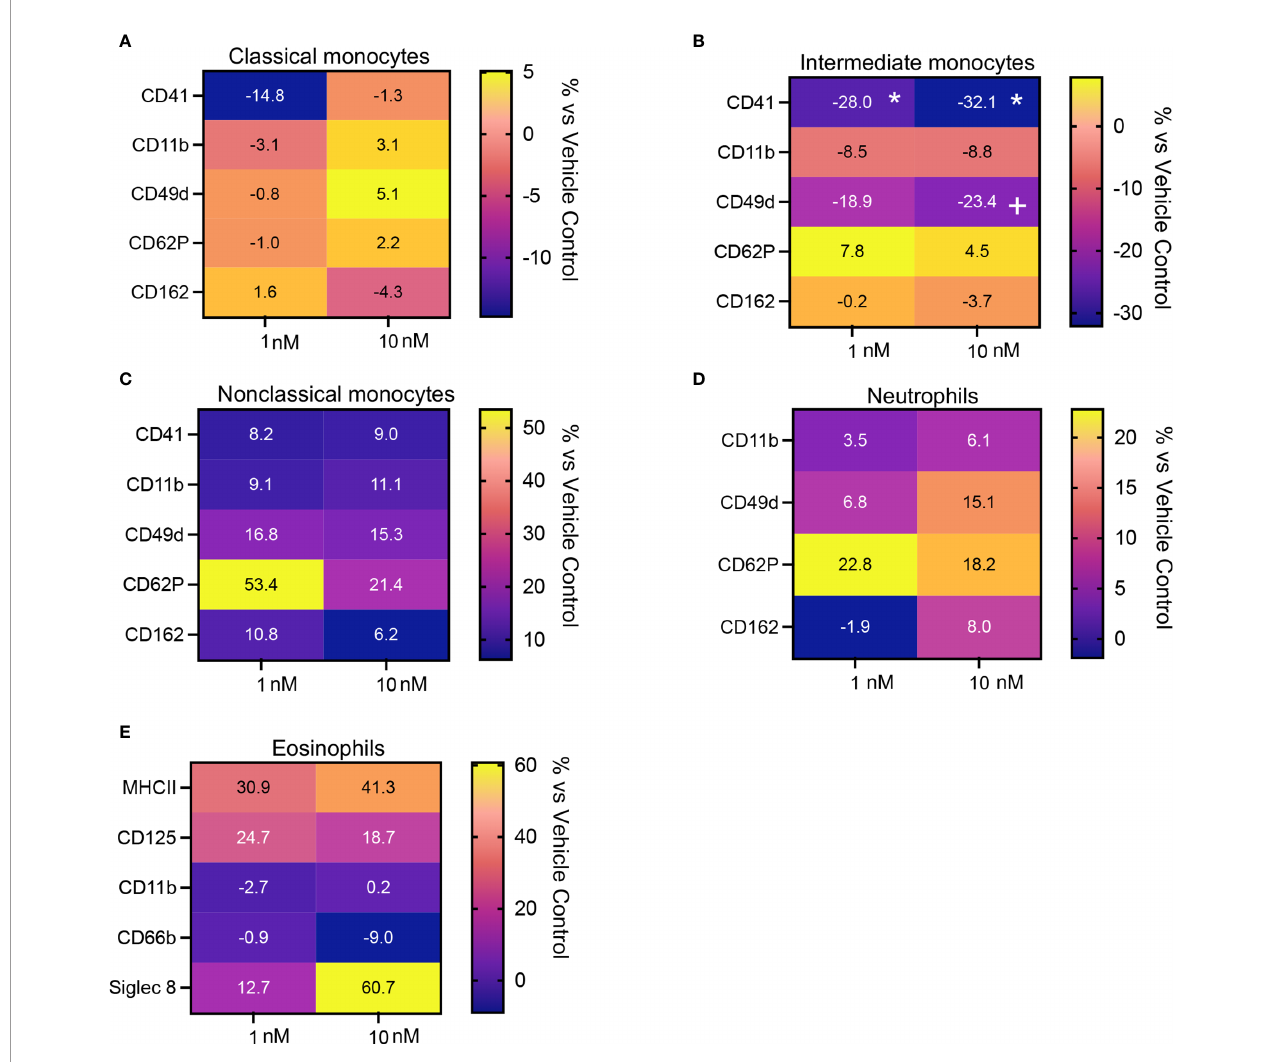
FIGURE 5 | MaR1 regulates the expression of activation markers on peripheral blood phagocytes from patients with CRSwNP. (A – E) peripheral blood from CRSwNP patients was incubated with vehicle or MaR1 (1 or 10nM) for 45 minutes at 37°C and the expression of the indicated activation markers was evaluated on (A) CD14++CD16+ Classical monocytes, (B) CD14++CD16++ Intermediate monocytes, (C) CD14+CD16++ Non-Classical monocytes, (D) CD16+ neutrophils and (E) Siglec 8+ eosinophils using fl ow cytometry. Results are means of percentage (%) change from values obtained in vehicle controls for each patient. N = 7 patients for (A – D) and 10 patients for (E) . *p <